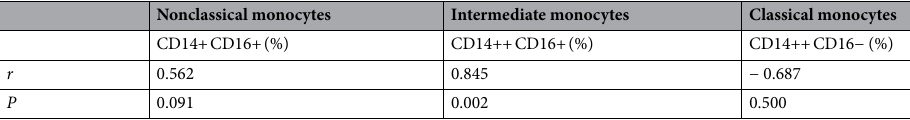
Table 3. Correlation between TRAb and percentage of monocyte subsets. Correlations were analyzed via Spearman’s correlation analysis.